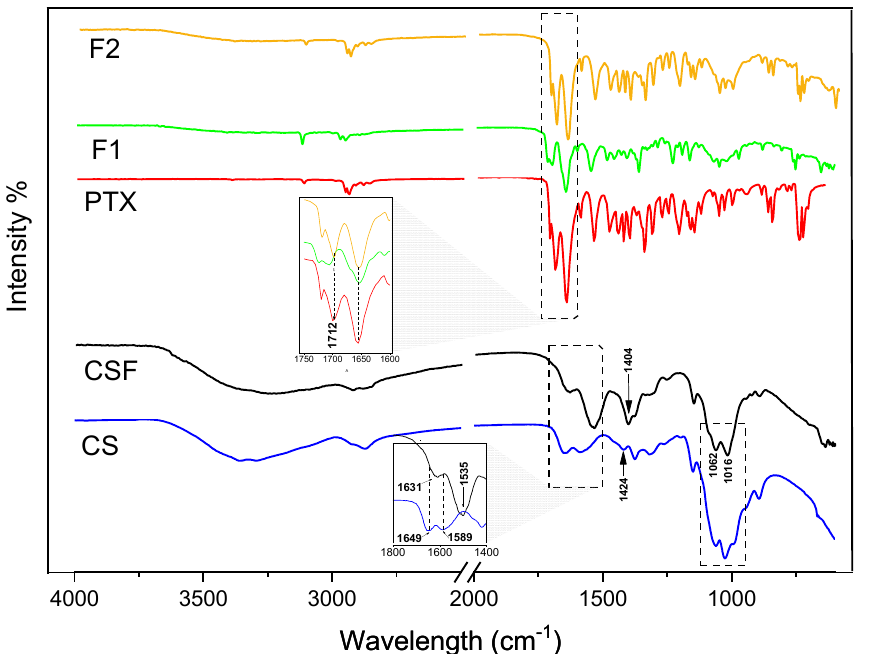
Figure 2. Fourier transform infrared spectroscopy of CS (chitosan, blue line), CSF (chitosan films, black line), PTX (pentoxifylline, red line), F1 (2 mg/mL of pentoxifylline, green line), and F2 (4 mg/mL of pentoxifylline, golden line) spectra.